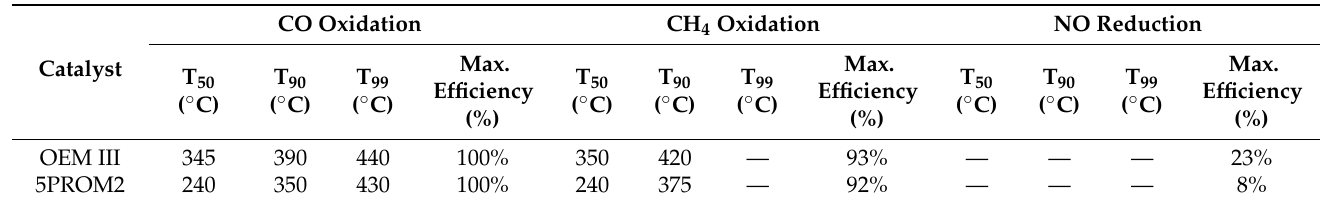
Table 4. Comparison of tested catalysts OEM III and 5PROM2 under lean-burn conditions ( λ = 1.03).